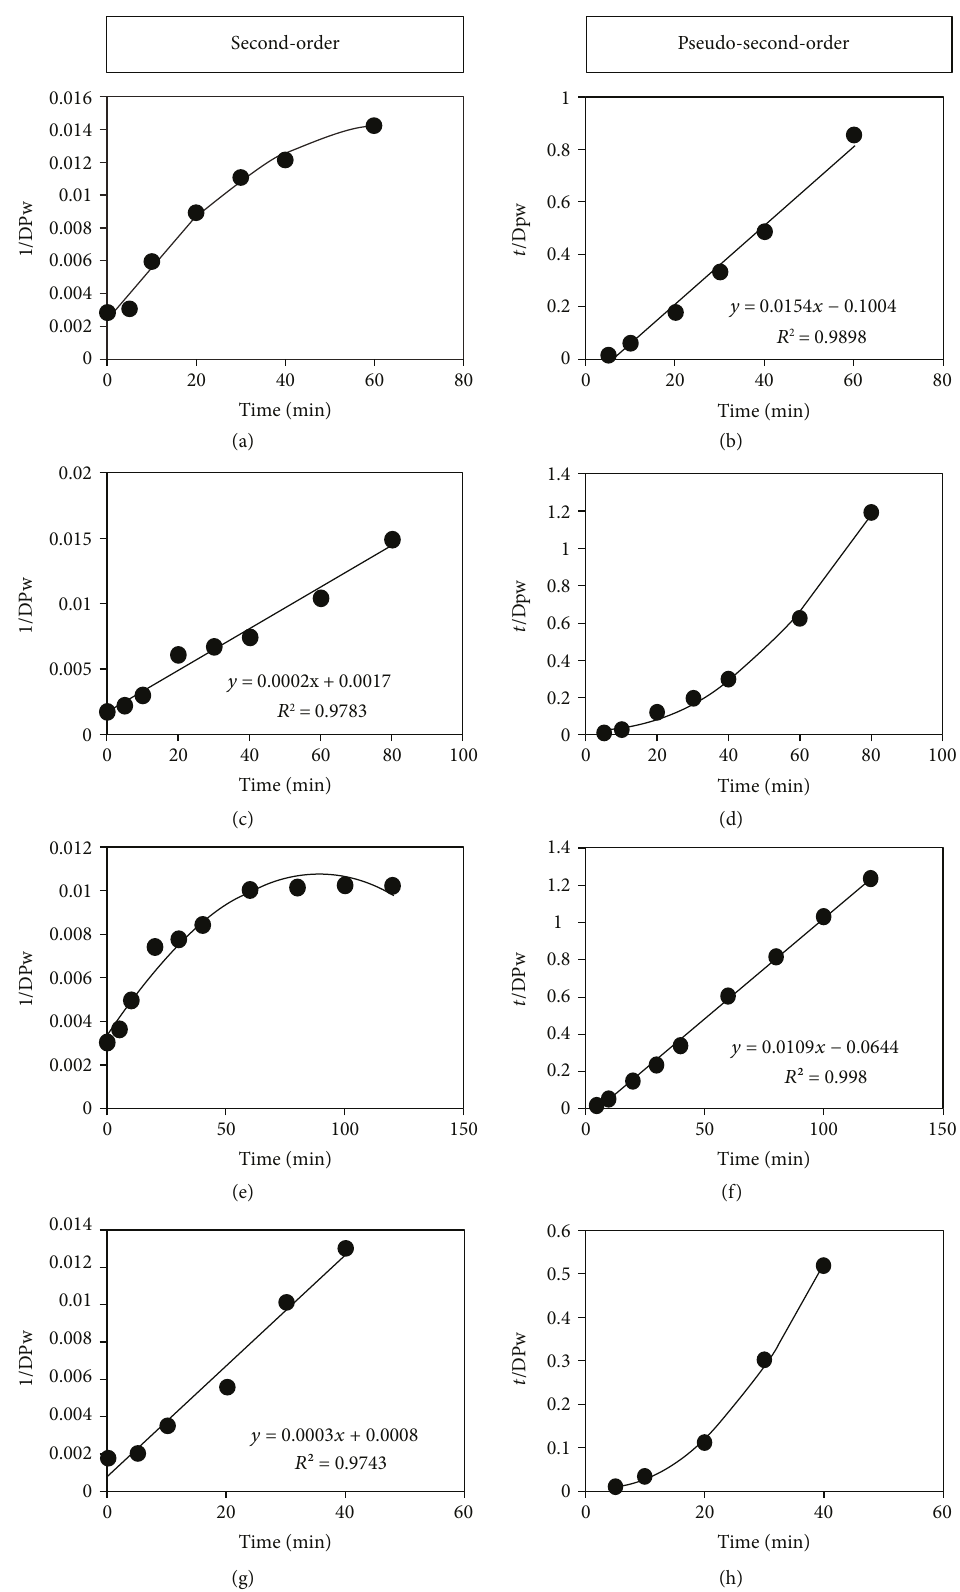
Figure 7: Second-order and pseudo-second-order kinetics for the depolymerization of cellulose fi bres derived from sawdust (a, b), sugarcane bagasse (c, d), corn cob (e, f), and sago pith wastes (g, h). (Reaction temperature = 80 ° C ; acid catalyst concentration = 0 23mmol H